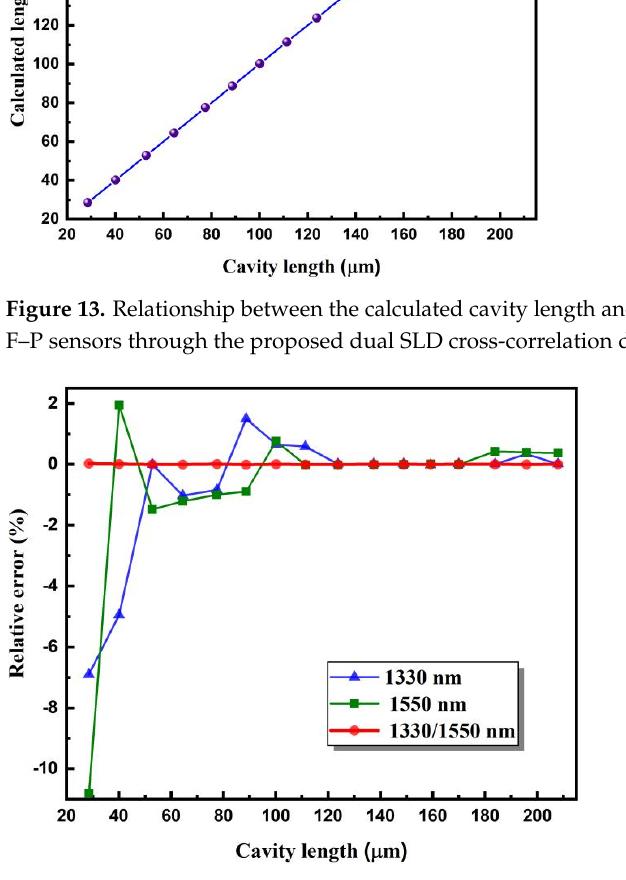
Figure 14. Demodulation deviations of fiber-optic F–P sensors with cavity lengths in the range of 20–200 µ m under different illuminating conditions of a single 1330 or 1550 nm SLD or two SLDs simultaneously.